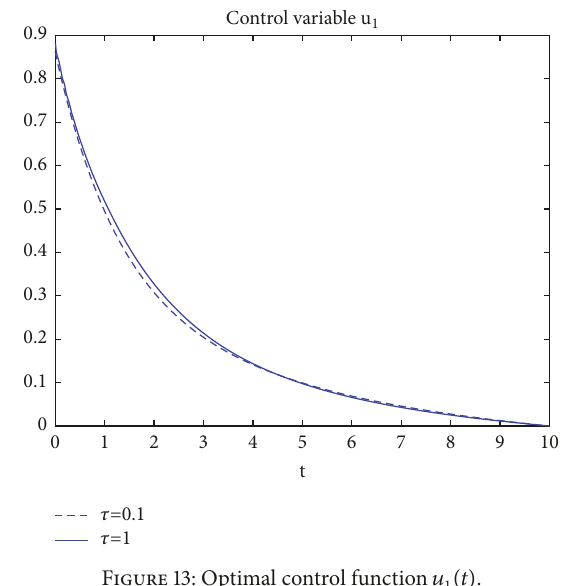
Figure 13: Optimal control function 𝑢 1 (𝑡) .